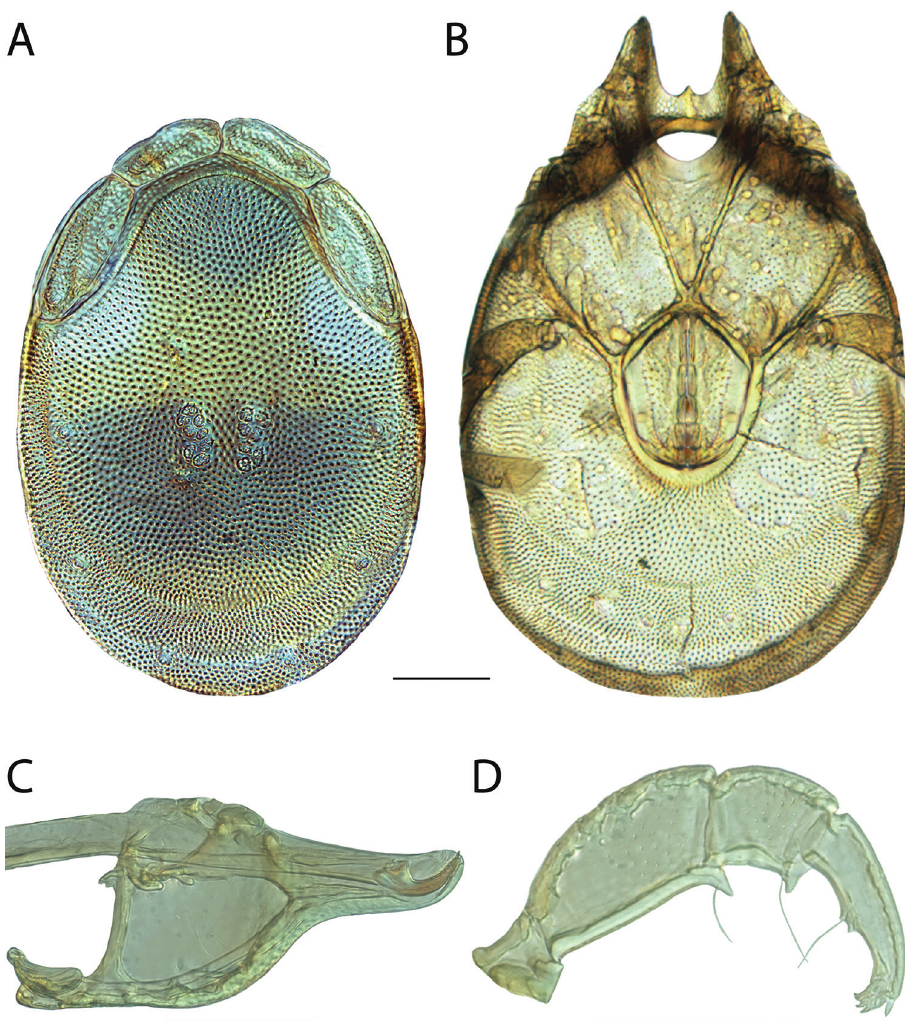
Figure 238. Torrenticola shubini sp. n. female: A dorsal plates B venter (legs removed) C subcapitulum D pedipalp (setae not accurately depicted). Scale = 100